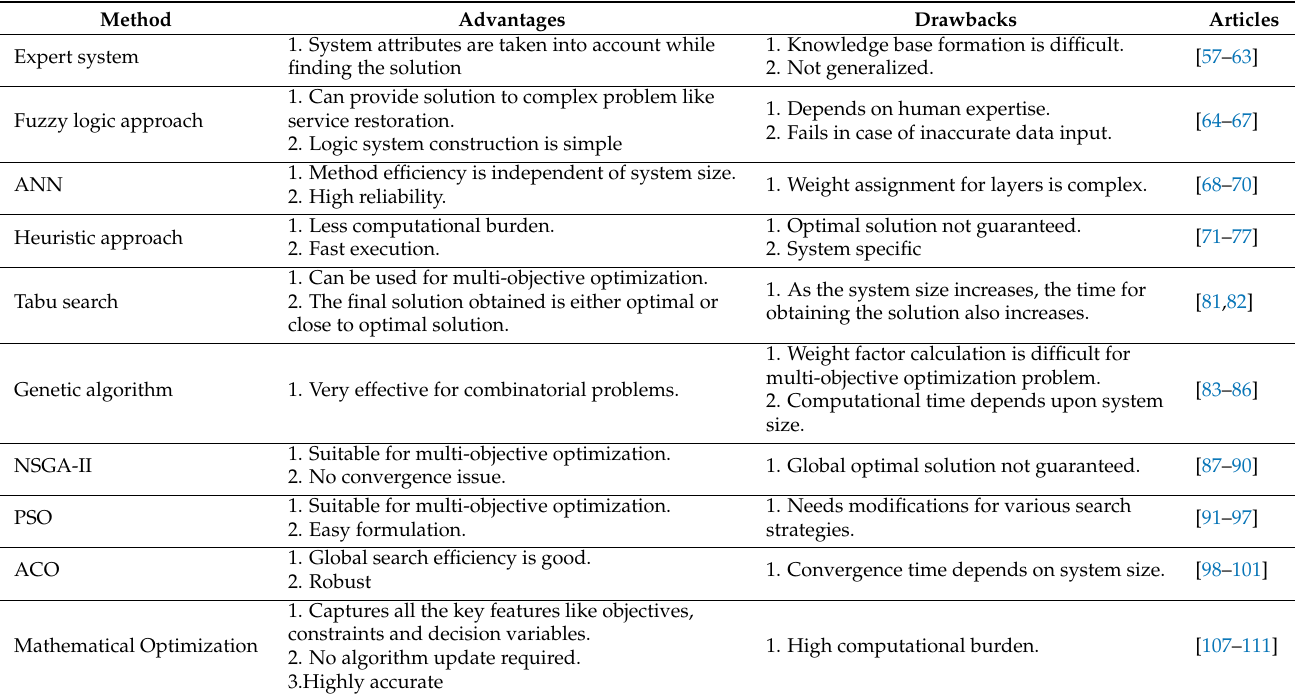
Table 2. Merits and demerits of various methods proposed for solving the service restoration